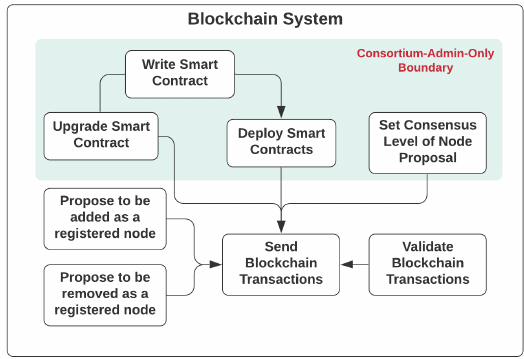
Figure 3. Use Cases of dNAS Blockchain System.